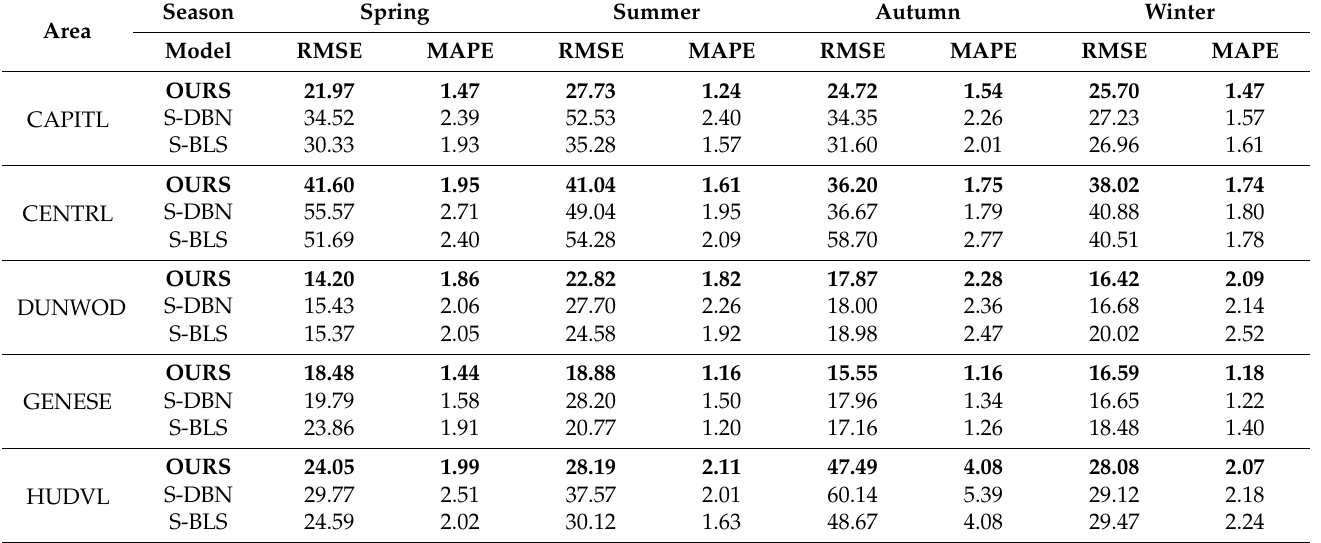
Table 3. The error of comparison with other ensemble models.